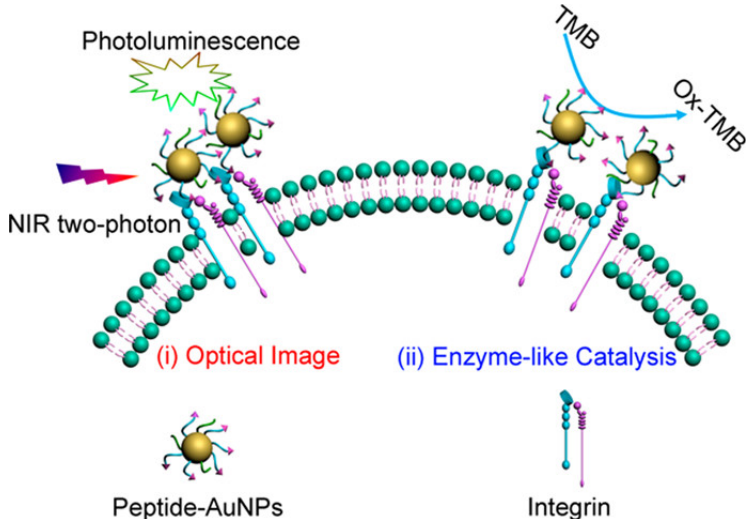
Figure 8. ( i ) Selective recognition-mediated coupling of gold nanoparticles inducing two-photon photoluminescence to display GPIIb/IIIa integrin on the surface of HEL cell. ( ii ) Intrinsic enzyme-like catalysis amplifying signal to sensitively and accurately quantify GPIIb/IIIa expression. Reprinted with permission from [132]. Copyright © 2015 American Chemical Society.